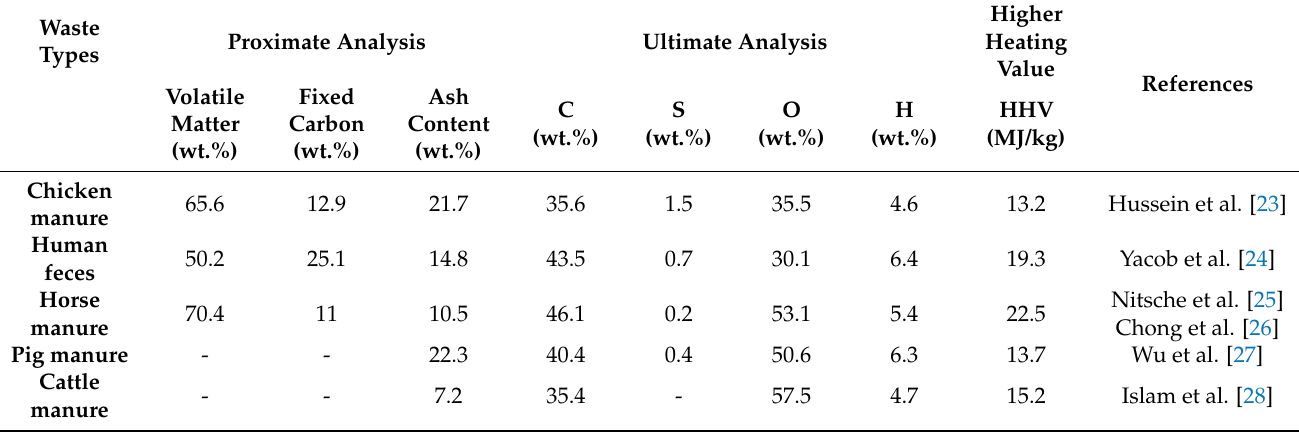
Table 3. Proximate and ultimate analysis of human and livestock wastes, expressed on a dry